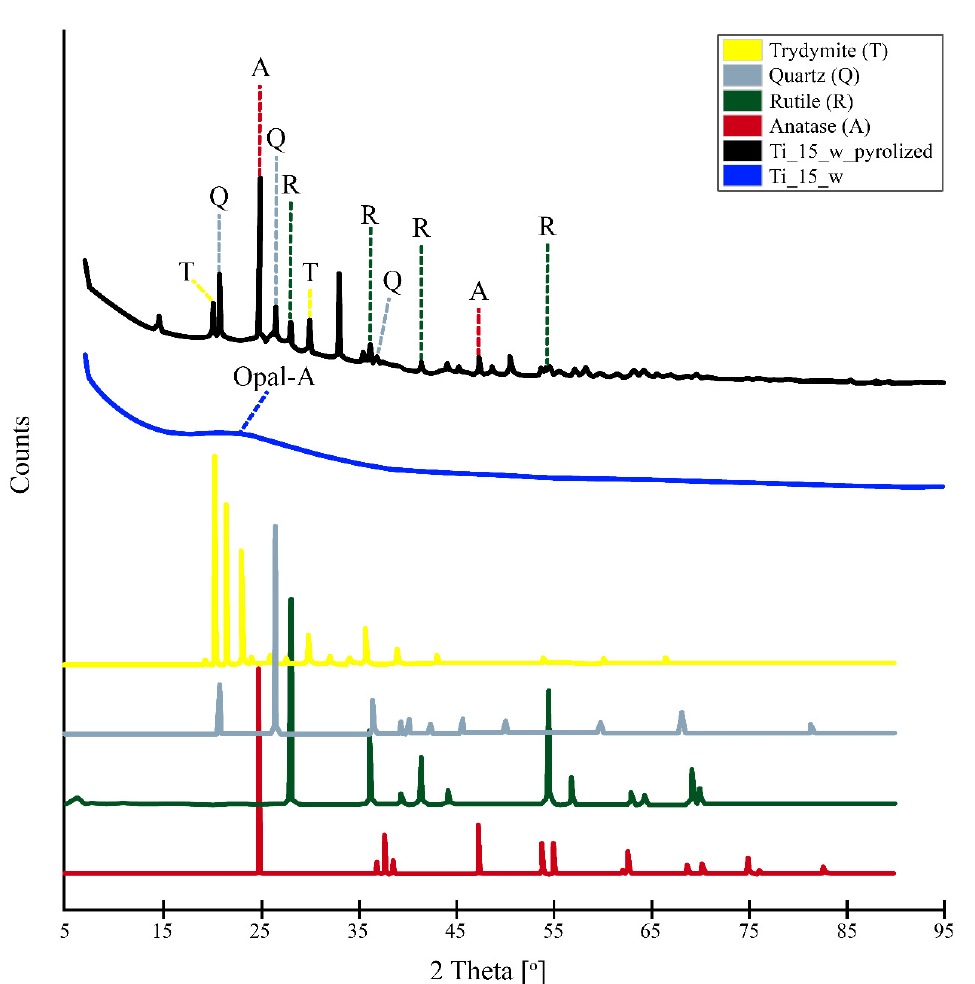
Figure 6. X-ray powder diffractograms of dried diatomaceous biosilica doped with titanium ions and diatomaceous Ti-biosilica subjected to pyrolysis at 1000 °C. XRD patterns for the patterns have